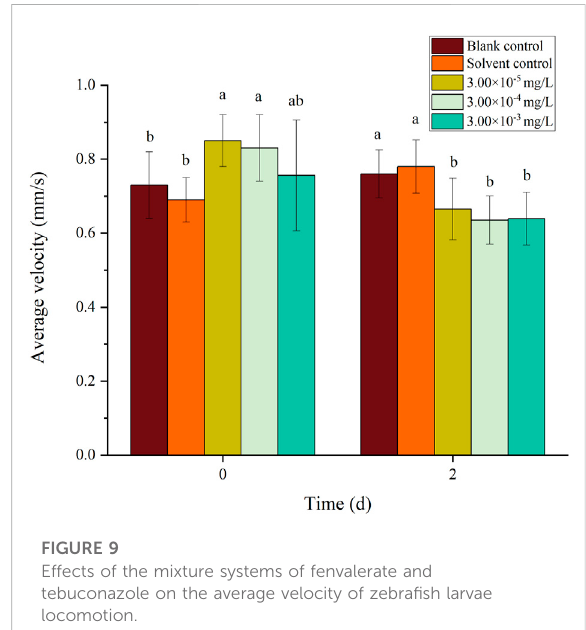
FIGURE 7 Effects of tebuconazole on the active time of zebra fi sh larvae locomotion.